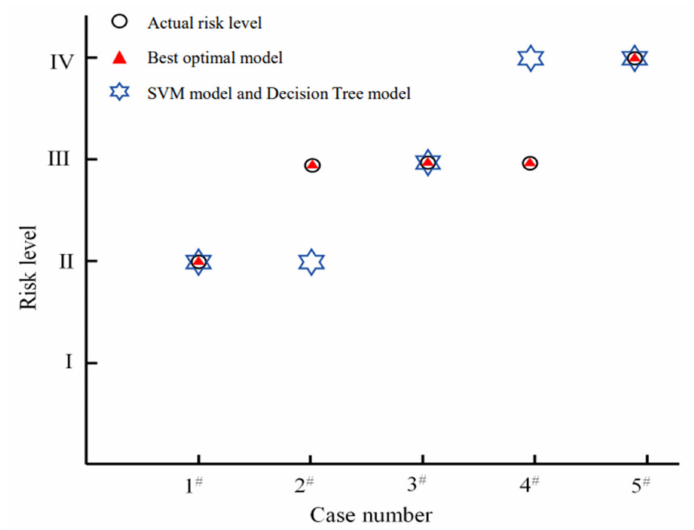
Figure 6. Comparison of prediction